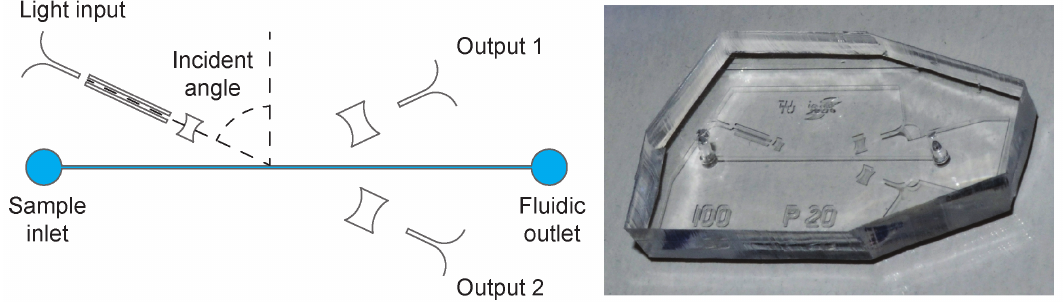
Figure 3. Schematic of the chip design on the left and photograph of one PDMS device on the right. The length of the microfluidic channel is 10.5 mm. More dimensions are given in [10] (Reproduced by permission of The Royal Society of